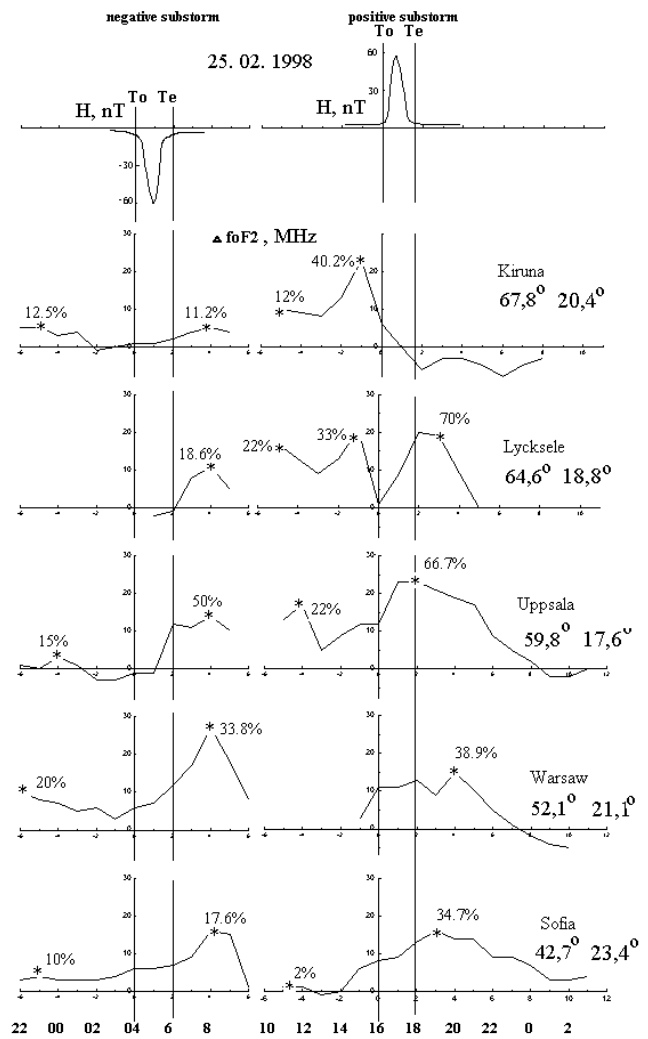
Fig. 5. The variations of the X -component magnetometer data from Sodankyla observatory for a positive and negative substorm that occurred on 25 February 1998, together with variations of 1 fo F2 from Kiruna, Lycksele, Uppsala, Warsaw and Sofia (LT = UT + 2). The vertical lines mark substorm onset, T o , and the end of the substorm, T e . Asterisks are δ fo F2 (%)